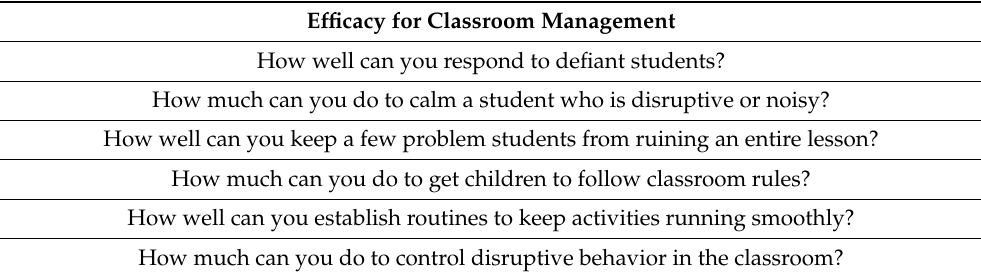
Table 4. Items making up the Efficacy for Classroom Management